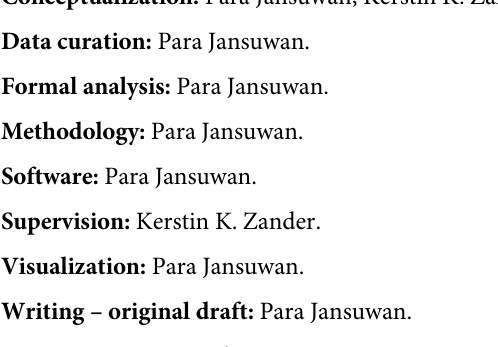
S4 Table. Perceived farming benefits. S5 Table. Result of the three final generalised structural equation models. S6 Table. Values of second-order bias-corrected Akaike information criterion (AICc) of the models for a) full-time profit-oriented farming type, b) full-time multifunctional farming type, and c) part-time farming type with different independent variable